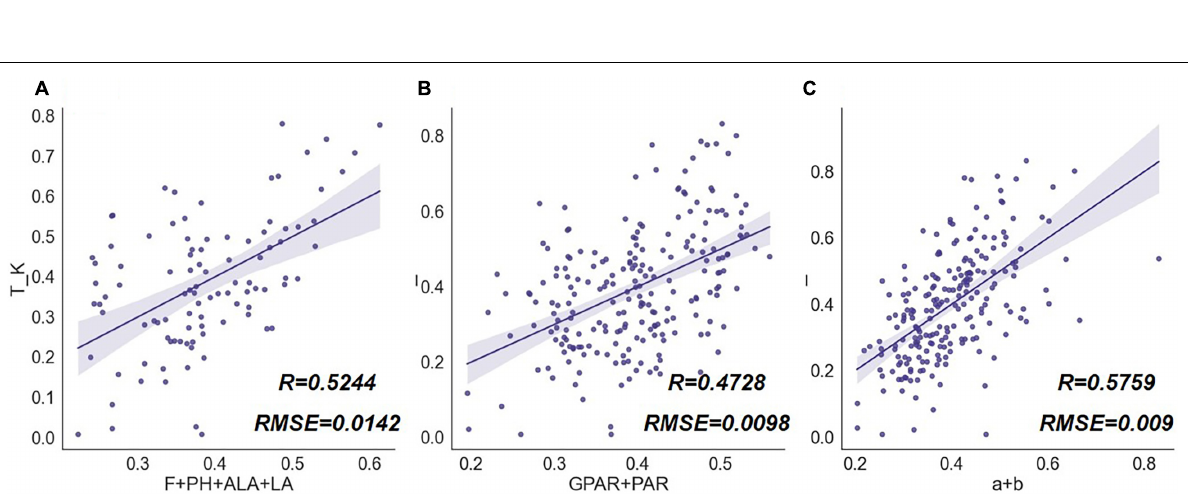
Frontiers in Plant Science |